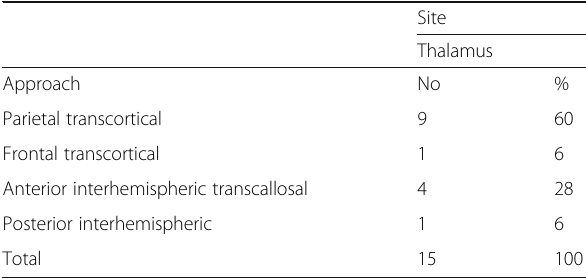
Table 3 Different microsurgical approaches